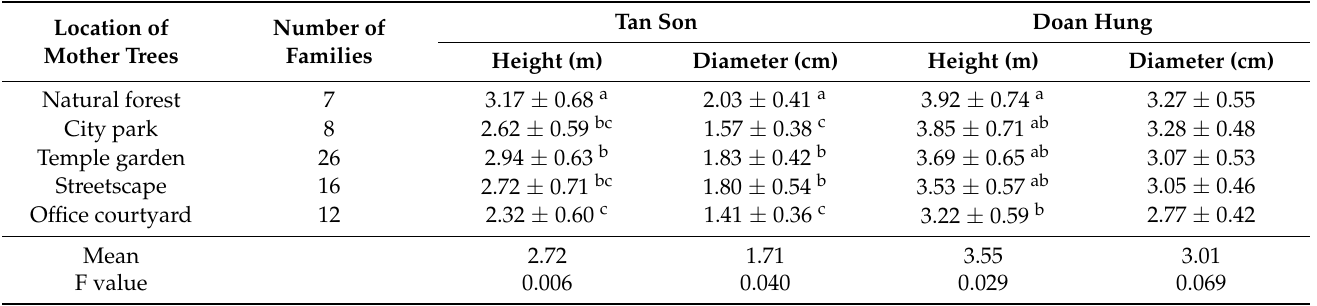
Table 4. Effect of location of mother trees on growth of Dalbergia tonkinensis at 3 years in field trials in Tan Son and Doan Hung. Different lowercase letters in a column indicate a significant difference according to DMRT at p <